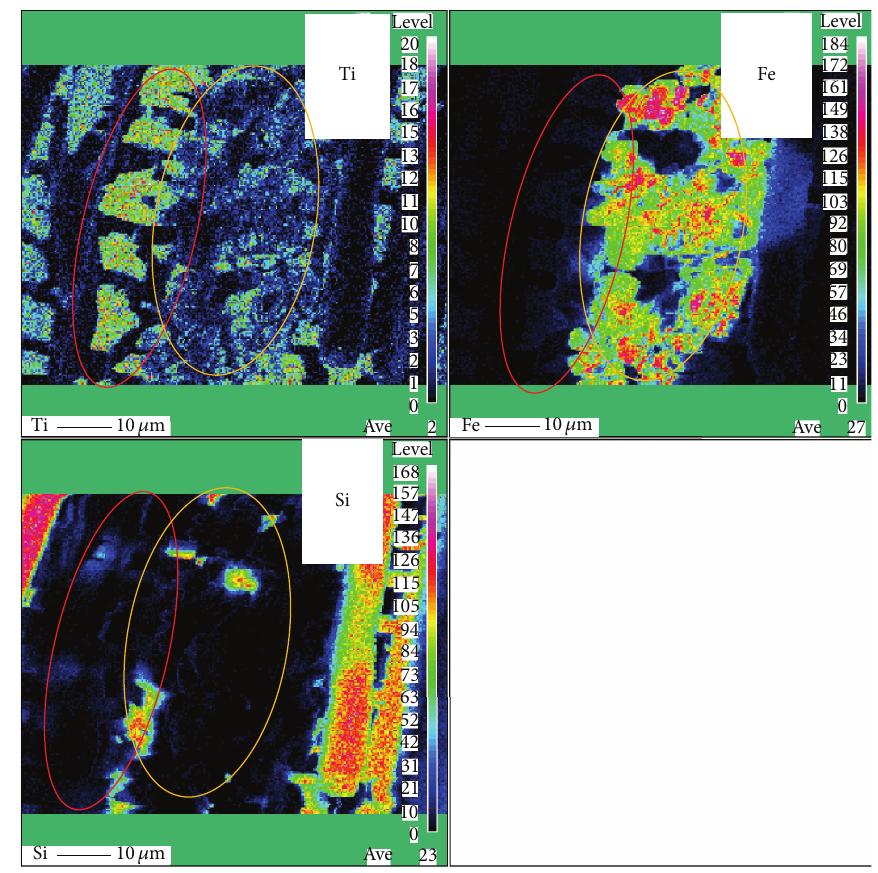
Figure 7: EPMA image of Fe/TiO 2 film coated on netlike glass disc.